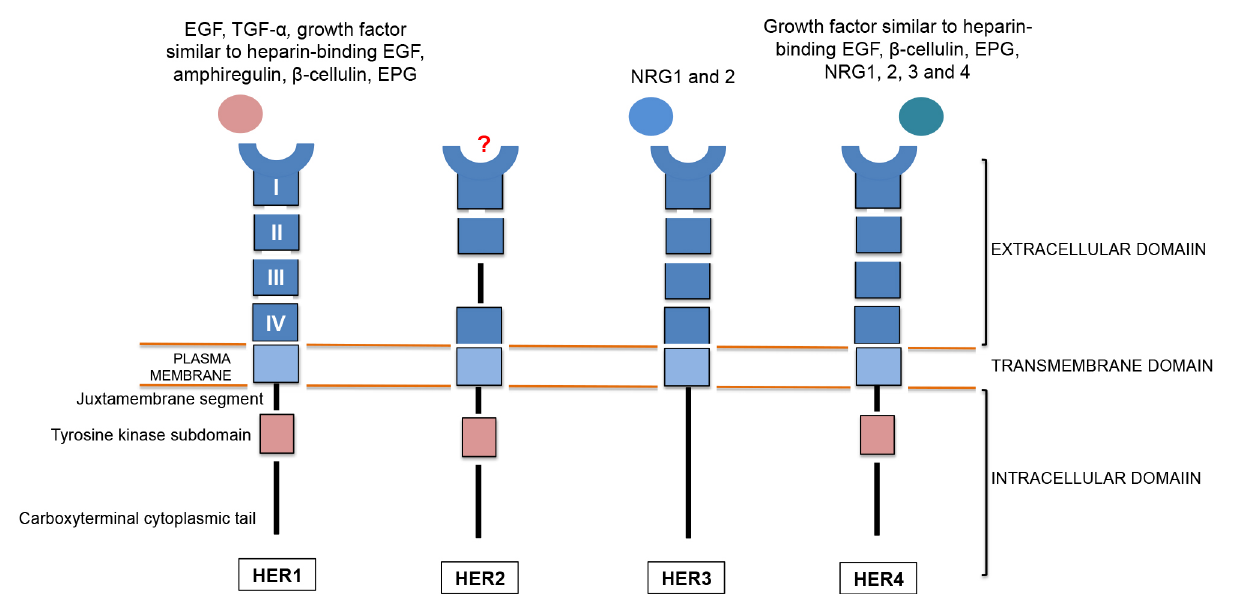
FIGURE 1 - General arrangement of receptors HER1/2/3/4 and their natural soluble ligands. The extracellular domain has four subdomains, and domains I and II are involved in binding the ligand. The carboxy-terminal tail contains tyrosine residues that can be phosphorylated. HER3 does not have a tyrosine kinase domain. To date, there are no known ligands for HER2. Epidermal growth factor (EGF), transforming growth factor alpha (TGF- α ), amphiregulin, β -cellulin, growth factor similar to heparin-binding EGF, epiregulin (EPG) and neuregulin